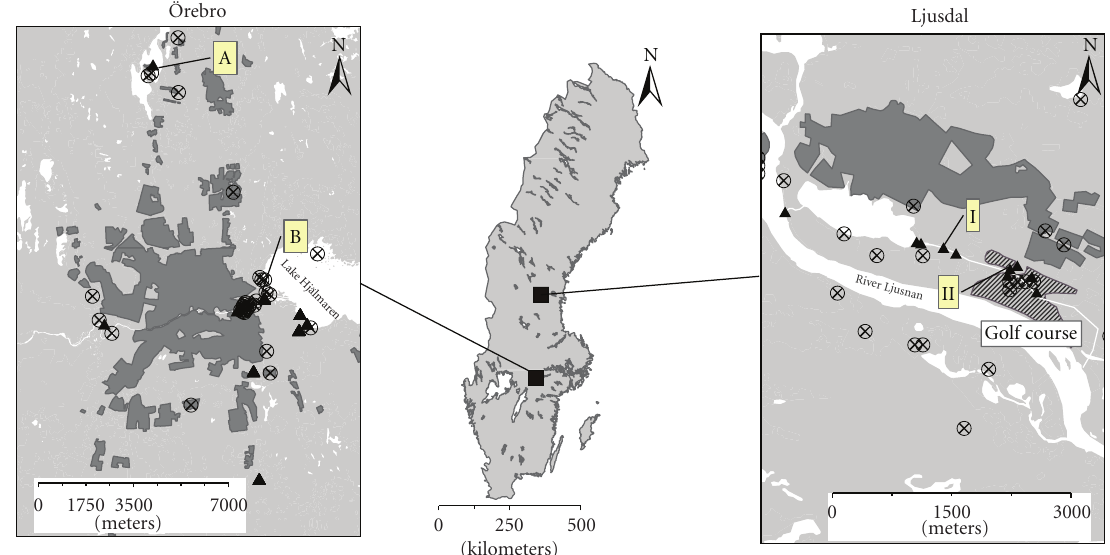
Figure 1: Sampling locations (black triangles), in the Ljusdal and the ¨Orebro area. Roman numerals (I, II) and letters (A, B) indicate sampling points selected for detailed analysis. Waterways are represented in white, urban areas are shaded. Each encircled × shows the probable place of disease transmission for patients infected in 1998–2005 (Ljusdal) and 2003-2004 ( ¨Orebro)